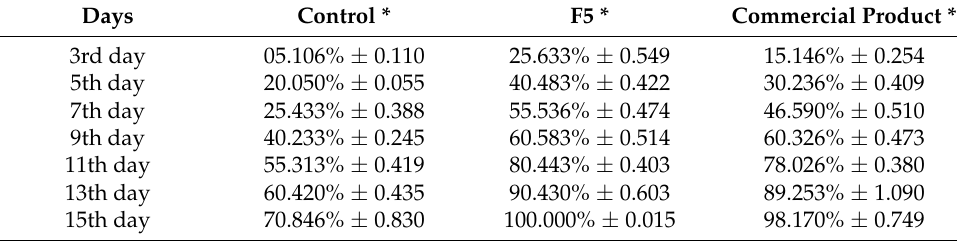
Table 7. Percentage of wound contraction for the F5, standard, and control groups (mean ±